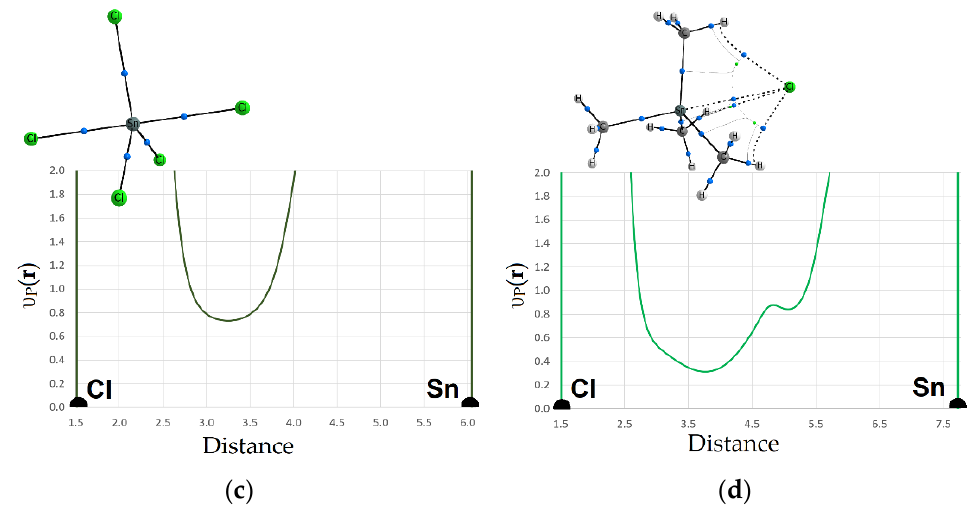
Figure 7. The distribution of Pauli potential (a.u.) along interatomic line Hal – …Tt in complexes ( a ) Cl–SiCl 3 …Cl – , ( b ) Cl–Si(CH 3 ) 3 …Cl – , ( c ) Cl–SnCl 3 …Cl – , and ( d ) Cl–Sn(CH 3 ) 3 …Cl – .